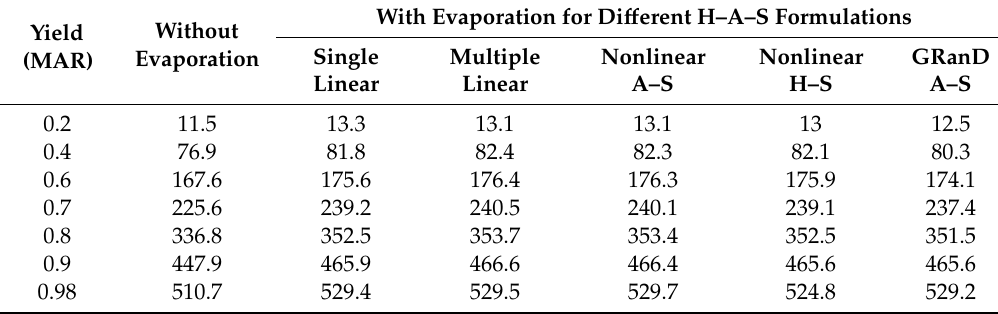
Table 3. Pong reservoir active storage-capacity estimates (10 6 m 3 ) .